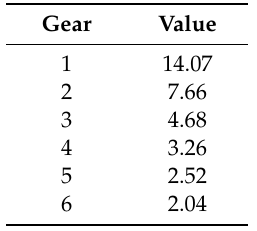
Table A2. Total gear ratios i G of the transmission.